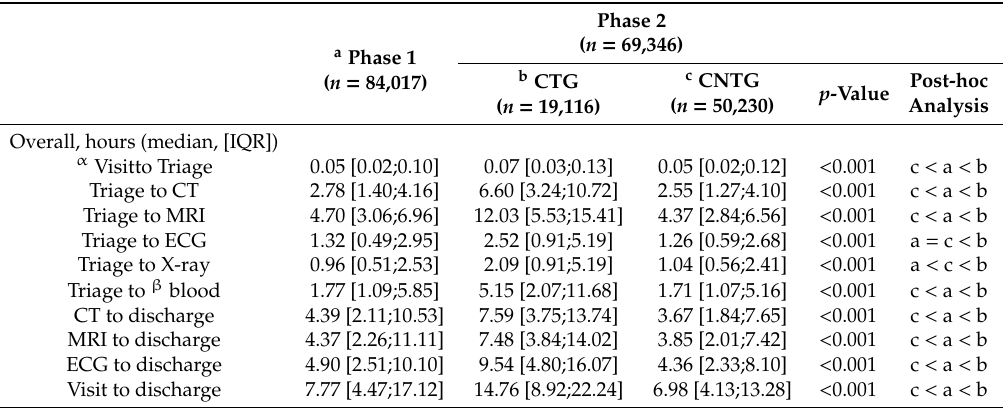
Table 2. Number of activities and duration of each process in the overall patient population.